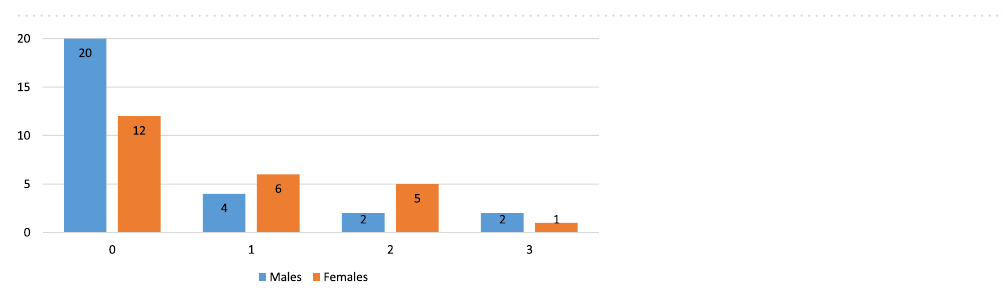
Figure 4. Survival curves for males (N = 28) and females (N = 24) of Eurasian lynx released in 2019–2021 (time expressed in days, shaded areas represent the 95% confidence interval).